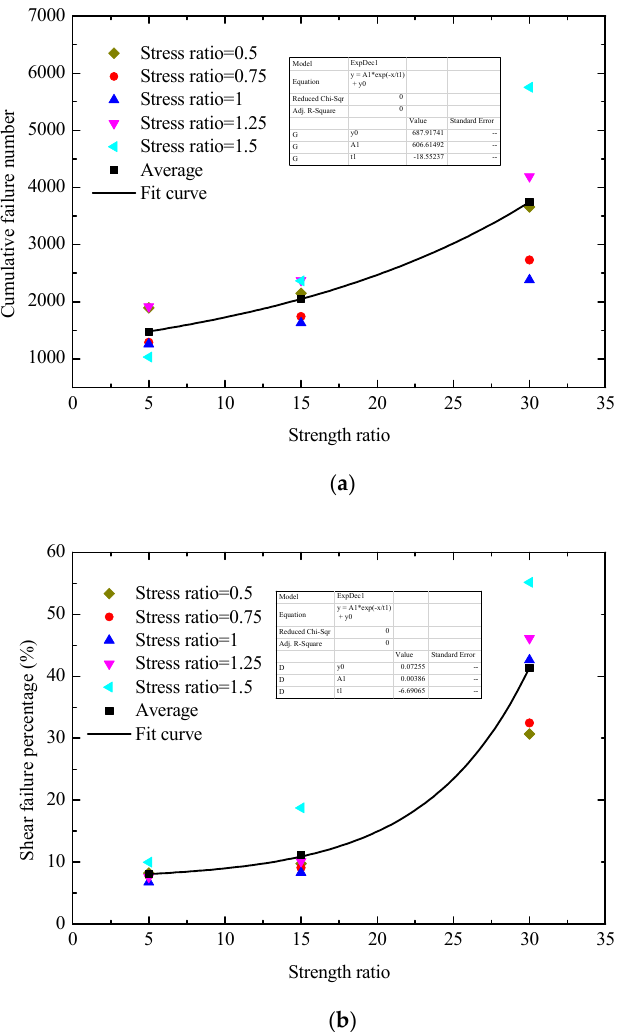
Figure 21. Changes of ( a ) Cumulative failure number and ( b ) Shear failure percentage with stress ratio